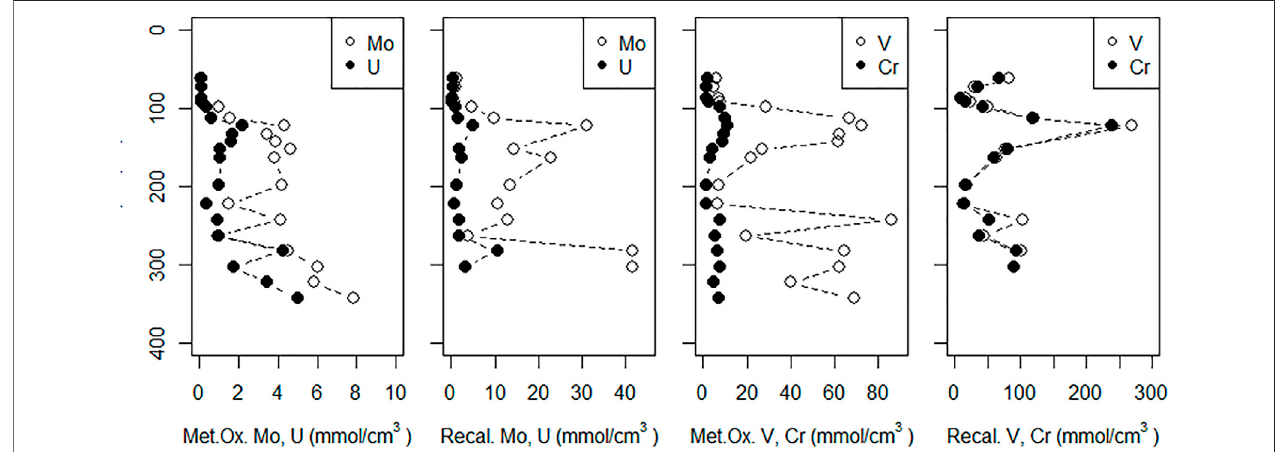
FIGURE 8 | Sediment concentrations of metals dissolved by reducing (Metal Ox.) and aqua regia (recalcitrant [Recal.]) leaches (described in Methods). The sediment core was taken adjacent to the MT pro fi le. The dotted line represents the sediment surface; depths are relative to the sediment surface at HT.